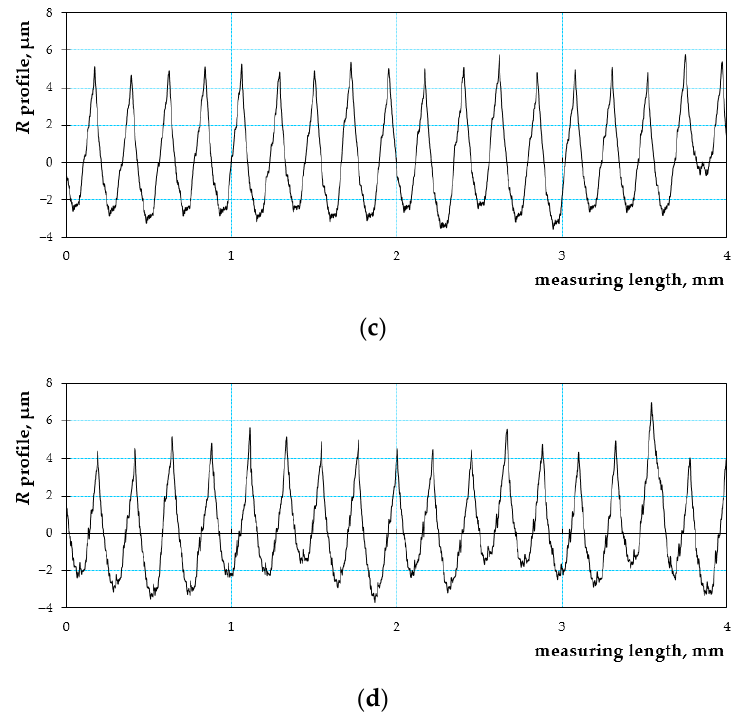
Figure 8. Roughness diagrams for various values of circular velocity of the working piece: ( a ) 200 m/min, ( b ) 240 m/min, ( c ) 280 m/min, ( d ) 400 m/min ( f = 0.22 mm).